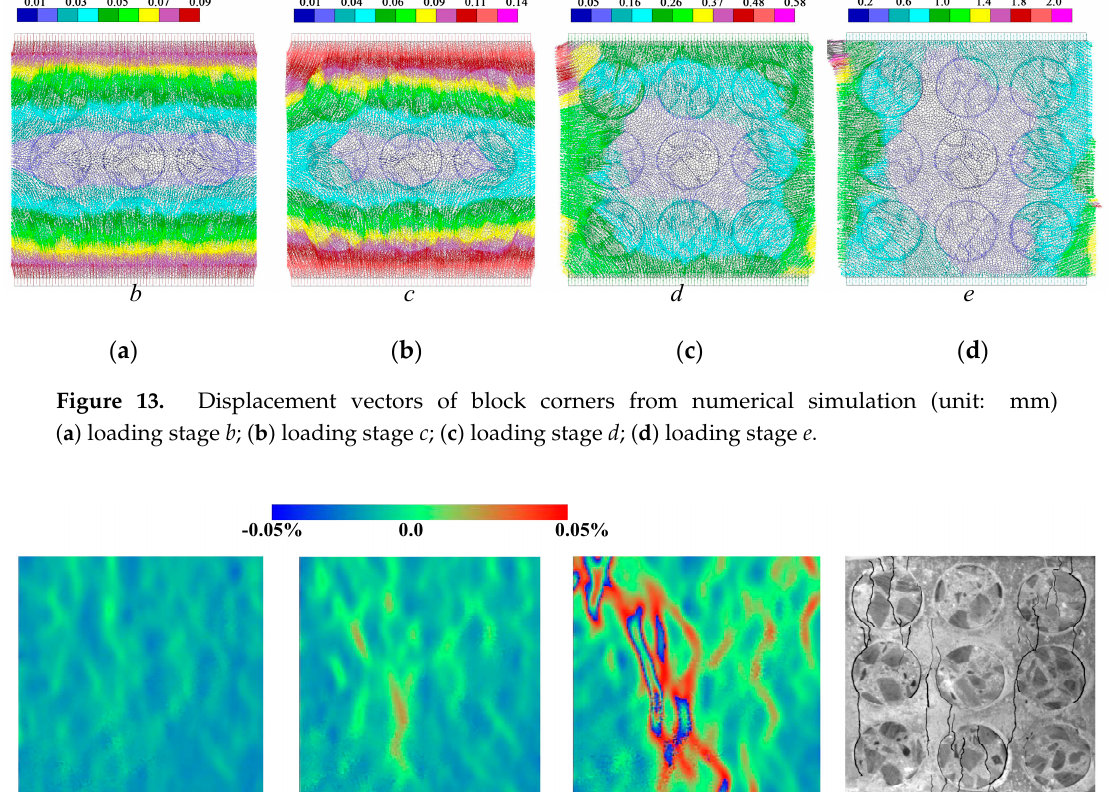
, which indicates